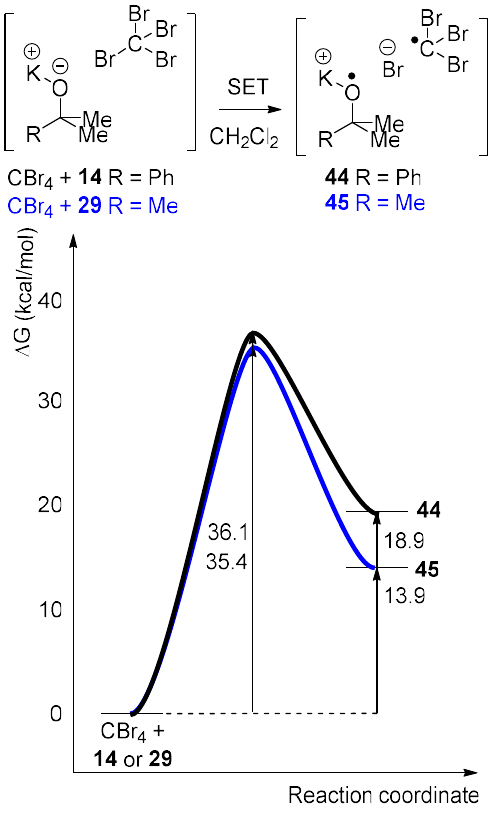
Figure 1. Computational modelling of SET from alkoxides, KO t Bu and potassium 2-phenylpropan-2- olate 14 to CBr 4 in dichloromethane.